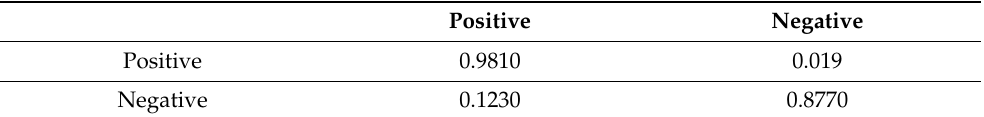
Table 21. Confusion matrix of the proposed ensemble model for D4, i.e., the Coswara breath- ing